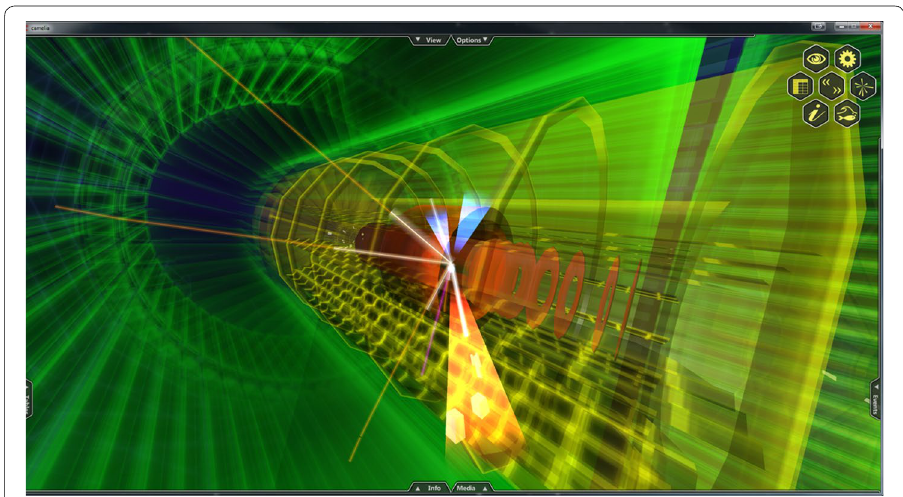
Fig. 23 A 3D visualization using the CAMELIA toolkit displayed on the Hiperwall that shows a subatomic particle decaying into several hadronic jets and leptons inside the ATLAS detector